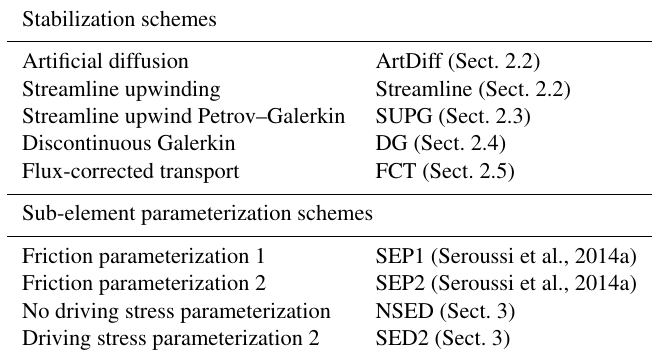
Table 1. List of the numerical schemes analyzed in this